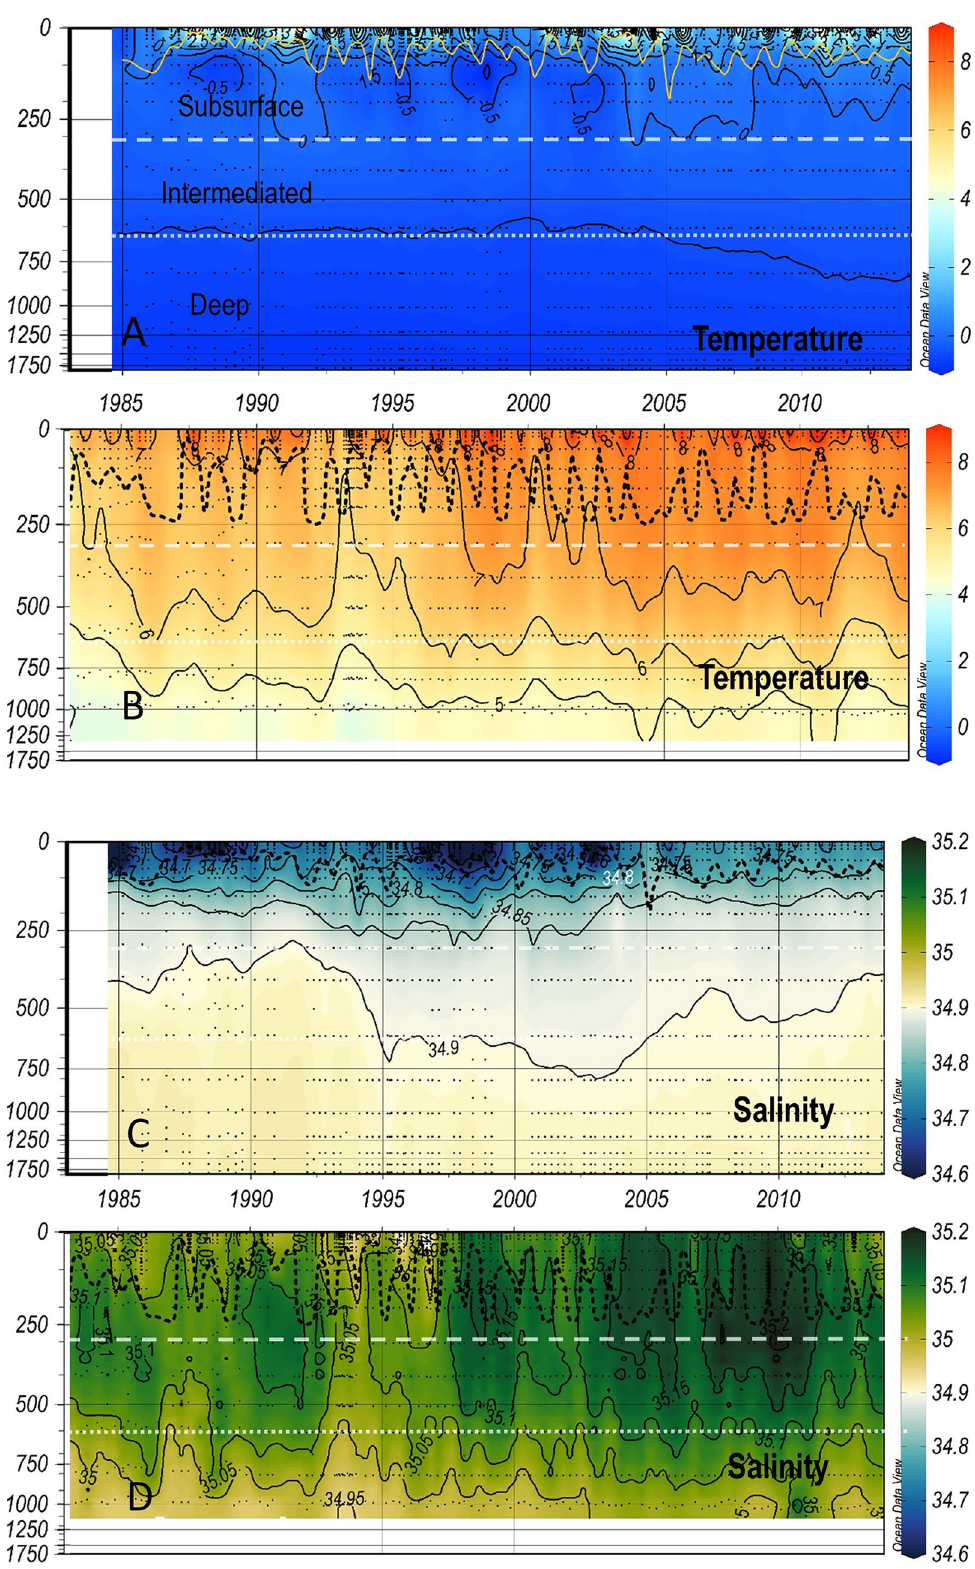
Figure 2. Vertical and time variation from 1983 (1985 for the IS-TS) to 2013 of temperature and salinity (black isolines and colour scale) at the IS-TS ( A , C ) and at the IRM-TS ( B , D ). The dashed black line shows the mixed layer depth that delimits the surface from the subsurface layers. The white dashed line separates the subsurface and intermediate layers, and the white dotted lines separate the intermediate and deep layers (labelled in A ). Figure prepared using Ocean Data View/DIVA 69 5.4.0 http:// odv. awi.